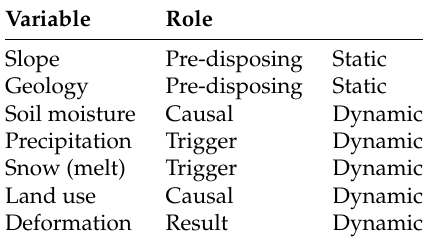
Table 1. Key variables in the landslide process that can be acquired from satellite observations. Variable Role Slope Pre-disposing Static Geology Pre-disposing Static Soil moisture